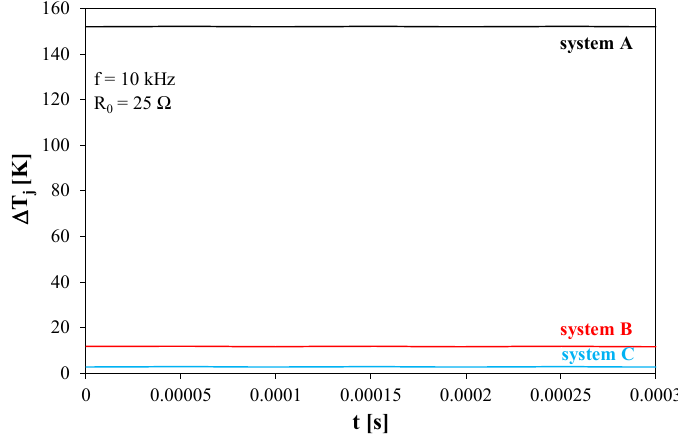
Figure 11. Waveforms of the junction temperature at the steady state for the transistor operating in the switch circuit and cooperating with all the considered cooling systems at frequency f = 10 kHz and load resistance R 0 = 25 Ω .